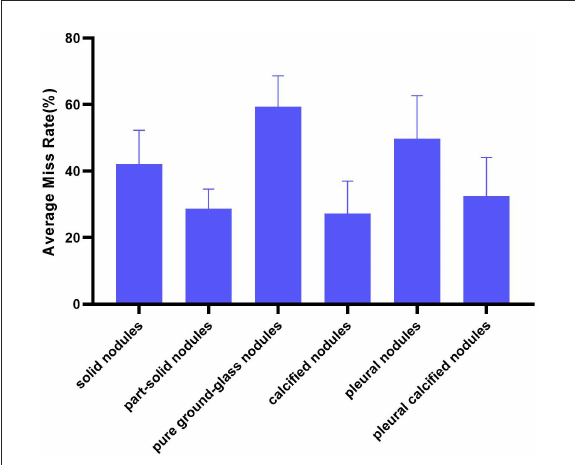
FIGURE6 The average miss rate of AUTs on the six types of nodules under the center